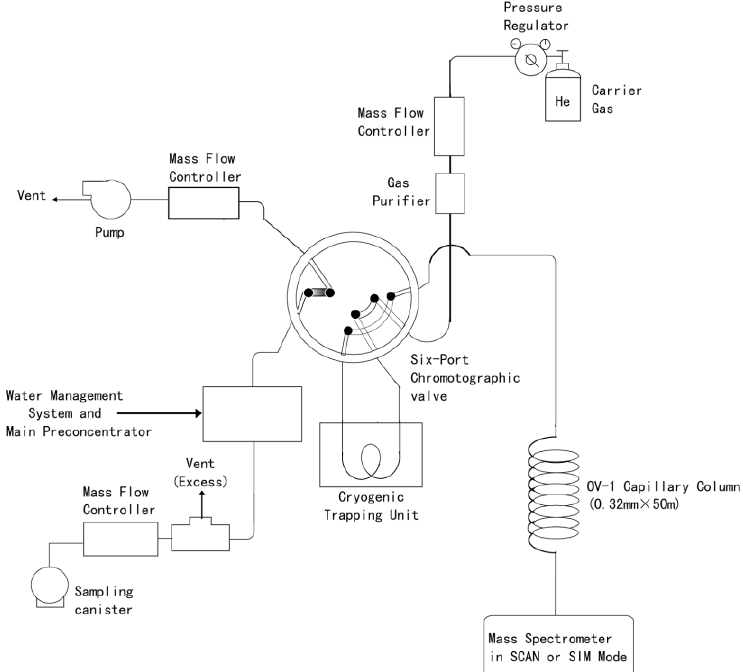
Figure 1. Schematic diagram of the Gas Chromatography/Mass-Selective Detection (GC/MSD)